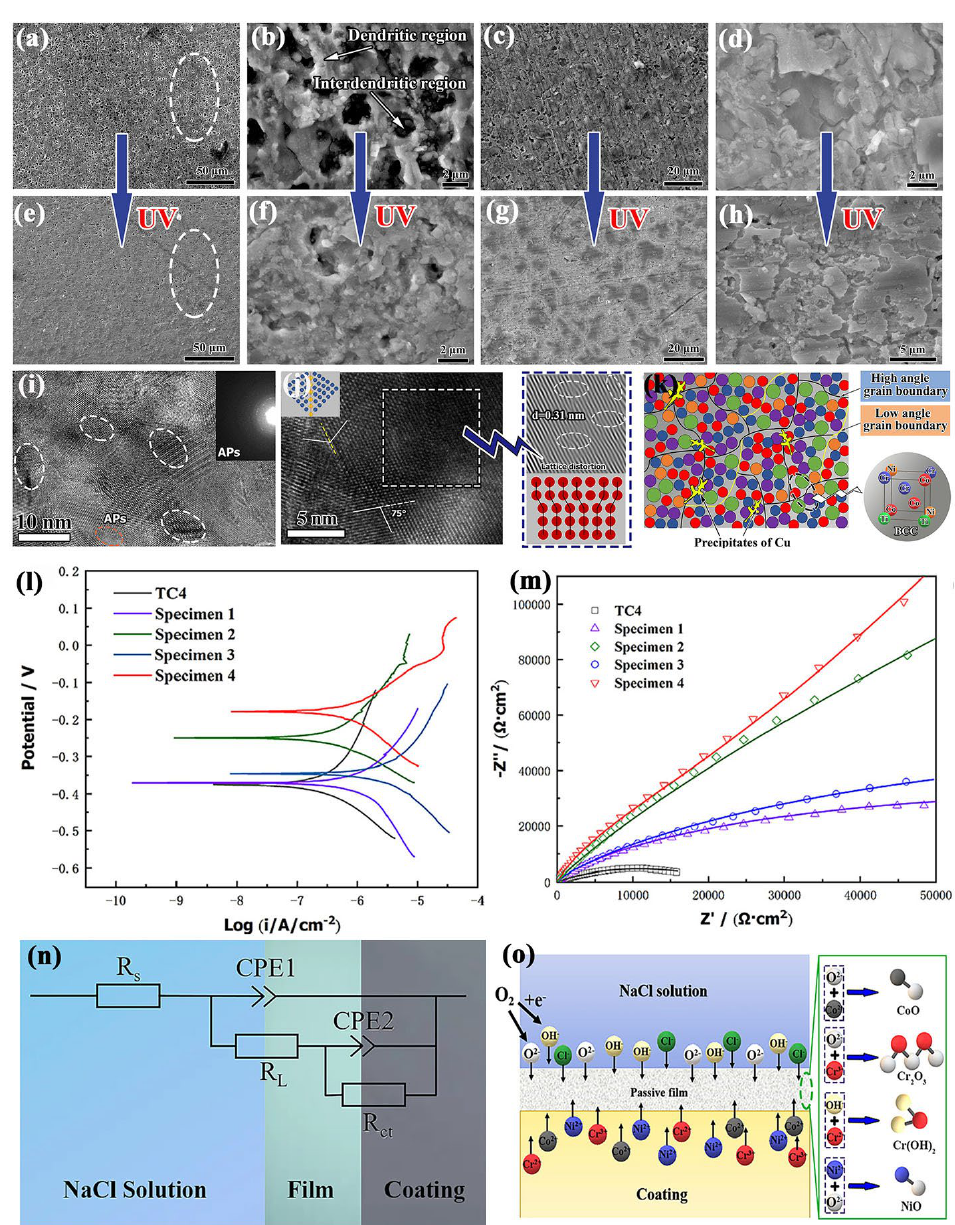
Figure 11. Microstructure and electrochemical performance of the CoCrNi-medium-entropy-alloy- based coating on TC4 substrates: ( a , b ) low laser power fabricated coating (specimen 1); ( c , d ) high laser power fabricated coating (specimen 3); ( e , f ) low laser power fabricated coating with UV (specimen 2); ( g , h ) high laser power fabricated coating with UV (specimen 4), ( i , j ) HRTEM image showing the substructure and crystal defects (the white dotted circles indicating formed dislocations); ( k ) schematic diagram of atomic structure; ( l ) Tafel polarization curves; ( m ) Nyquist plots in 3.5 wt% NaCl solutione; ( n ) equivalent circuit diagram, and ( o ) schematic diagram of the corrosion mechanismm (Reprinted from Ref. [216] with the kind permission of Elsevier).